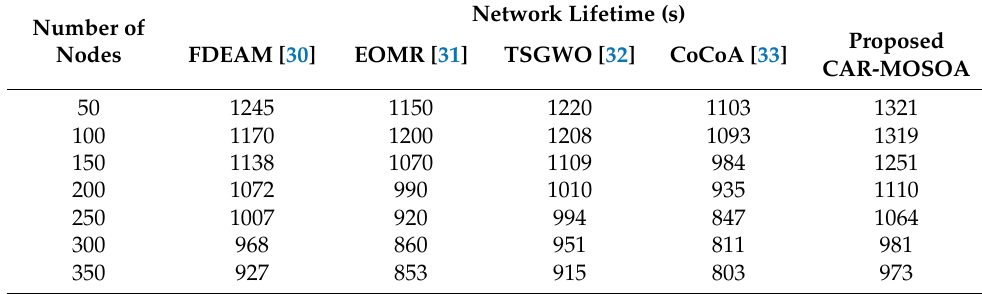
Figure 7. Performance based on network lifetime. Table 5. Comparative analysis of network